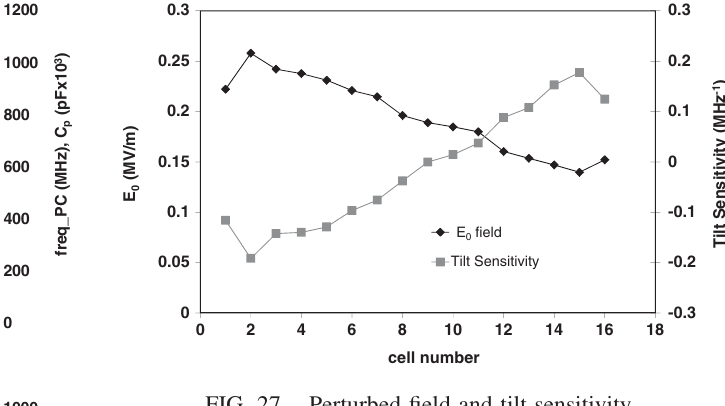
FIG. 27. Perturbed field and tilt sensitivity.